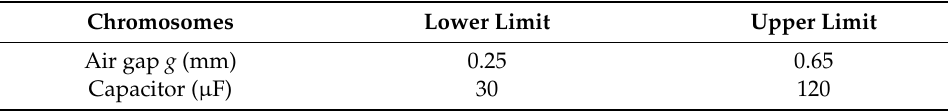
Table 2. Chromosomes and their limits.